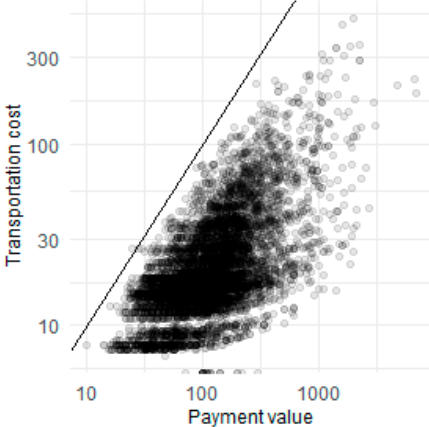
Figure 5. Scatterplot of transportation value and order value. Note: The logarithm of both axes is